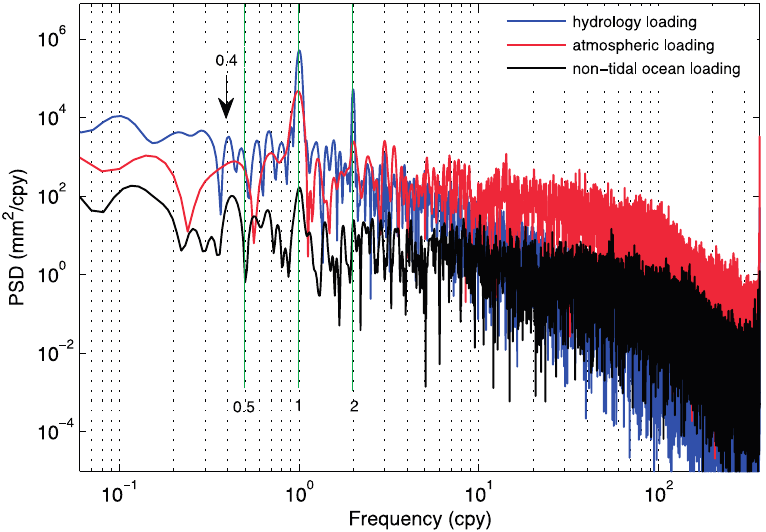
Figure 7. Power spectra density (PSD) of hydrology loading, atmosphere pressure loading and non-tidal ocean loading at LHAZ region corresponding to LHAZ GPS station in China. Blue, red and black curves denote the PSDs of the hydrology loading, atmosphere pressure loading, and non-tidal ocean loading,